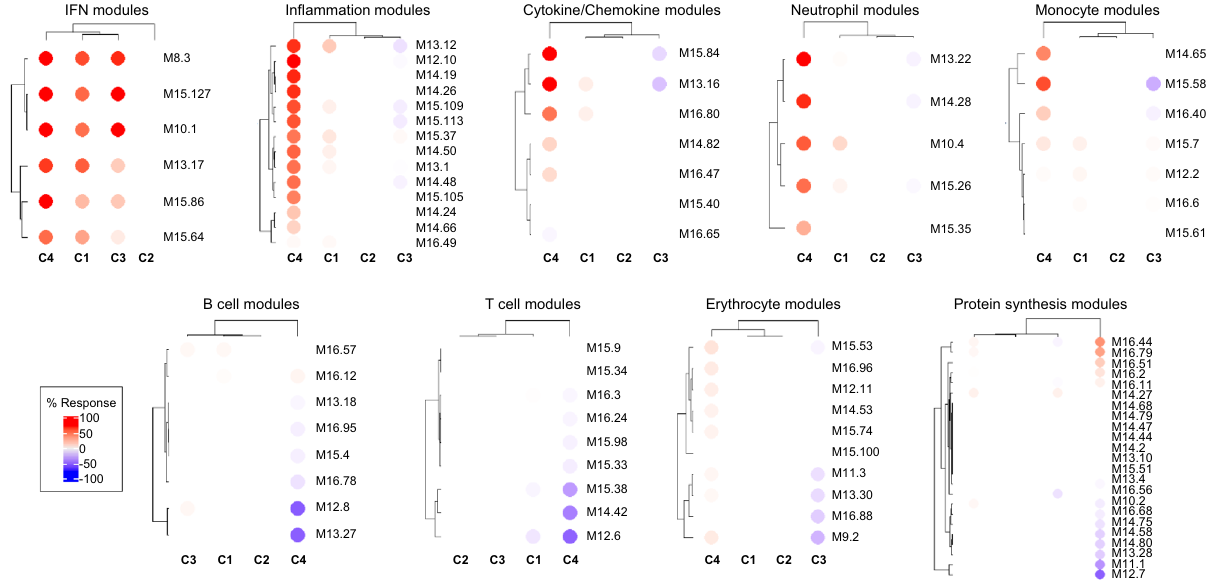
Fig. 2 Patterns of abundance of the different modules distinguish the four pSS clusters. Each heatmap, achieved with BloodGen3Module R package 9 , represents one of the most signi fi cant patterns differentiating the four clusters of 304 pSS patients (C1: 101, C2: 77, C3: 88, and C4: 38) compared to 330 healthy volunteers (HV). These patterns correspond to modules associated with IFN, neutrophils, in fl ammation, cytokines/chemokines, protein synthesis, erythrocytes, monocytes, B cells and T cells. Columns on this heatmap corresponds to clusters. Each row corresponds to one of the modules associated with the pattern. For each module, the percentage of increased genes (from 0 to 100) and decreased genes (from 0 to 100) were calculated. A red spot on the heatmap indicates an increase in abundance of transcripts comprising a given module for a given cluster. A blue spot indicates a decrease in abundance of transcripts. The absence of color indicates no